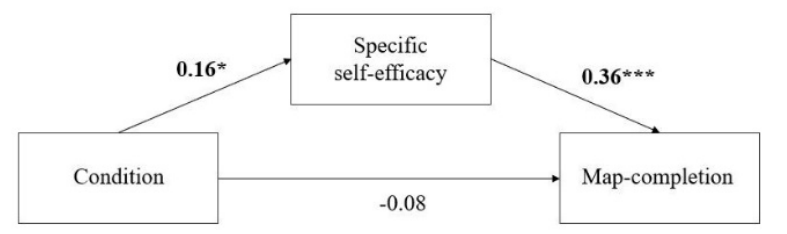
* p < 0.05; *** p < 0.001. Figure 5. Mediation models of the effect of positive feedback on performance in map completion.